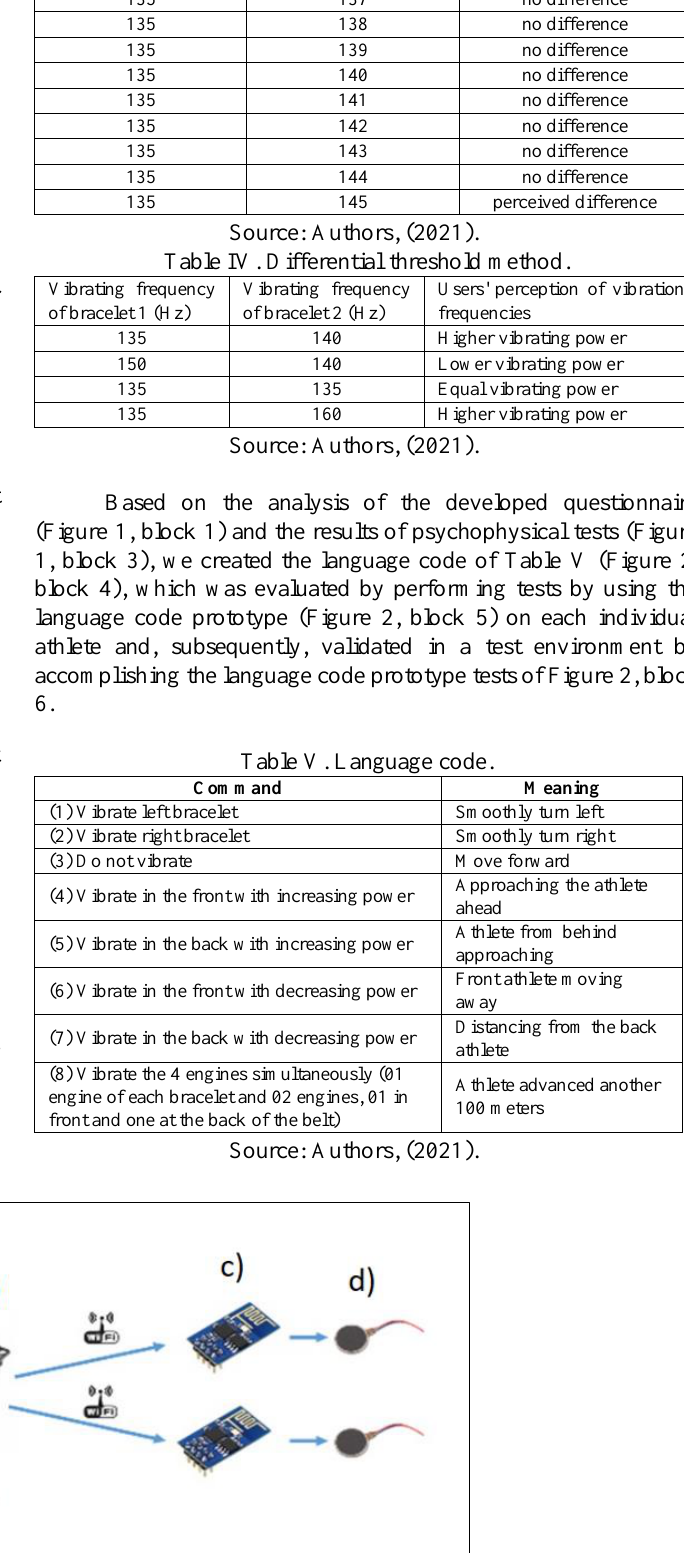
Figure 3: Language code